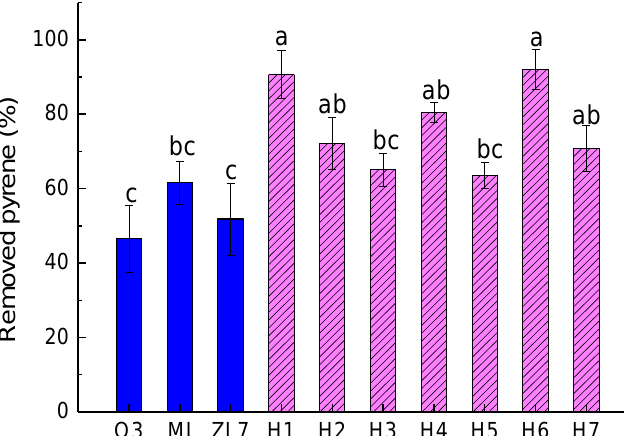
Figure 1. Antagonistic test of tested strains.